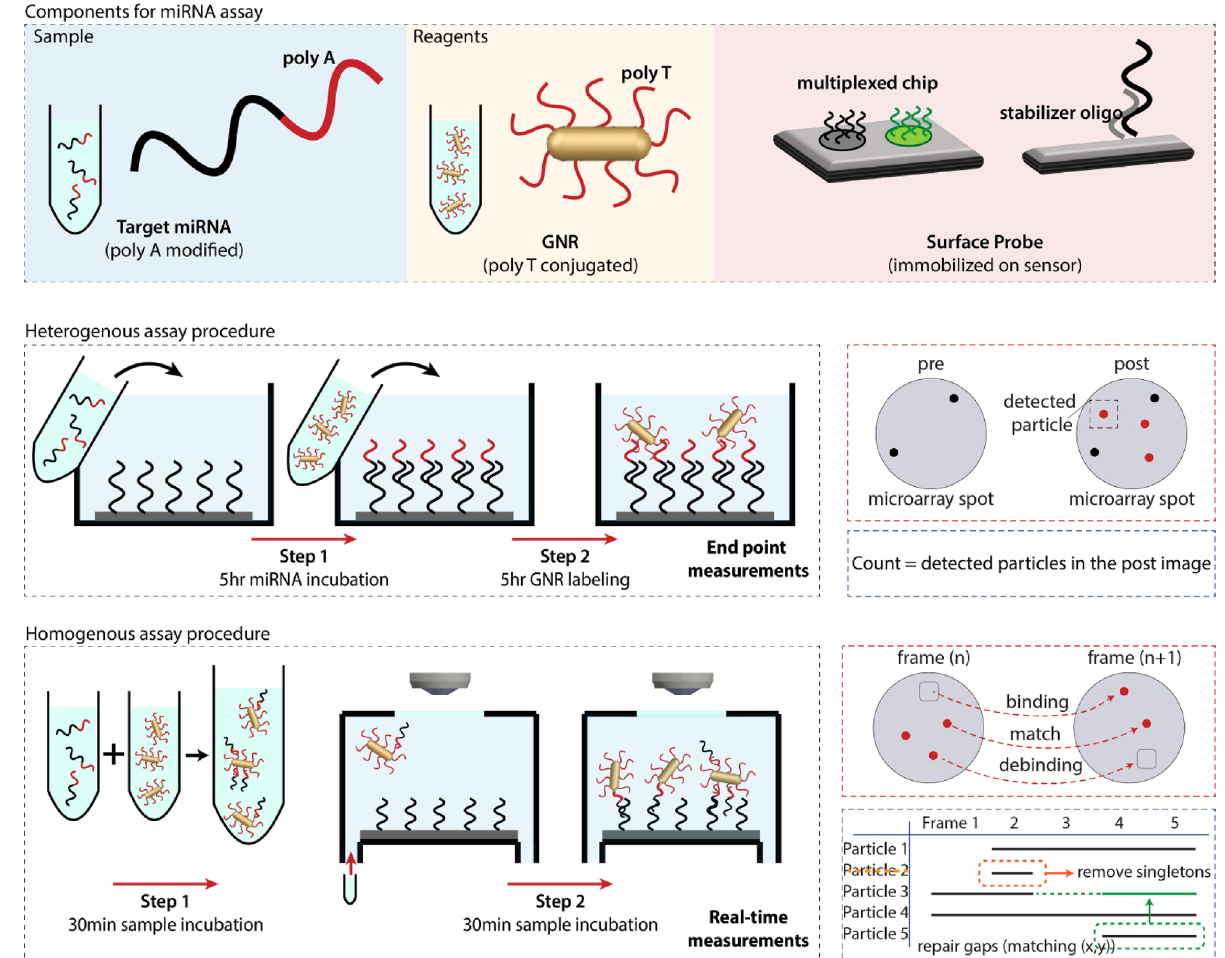
Figure 2. Components for the miRNA assay and experimental steps of heterogeneous and homogeneous assay